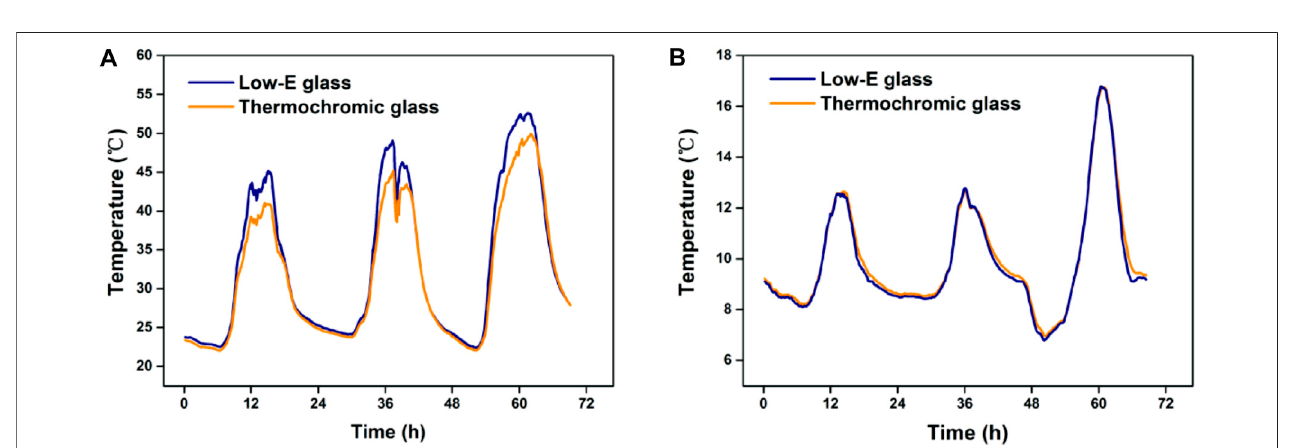
FIGURE 7 | Comparison of temperature between thermal dimming glass and Low-E glass sunlight room in summer (A) and winter (B) .